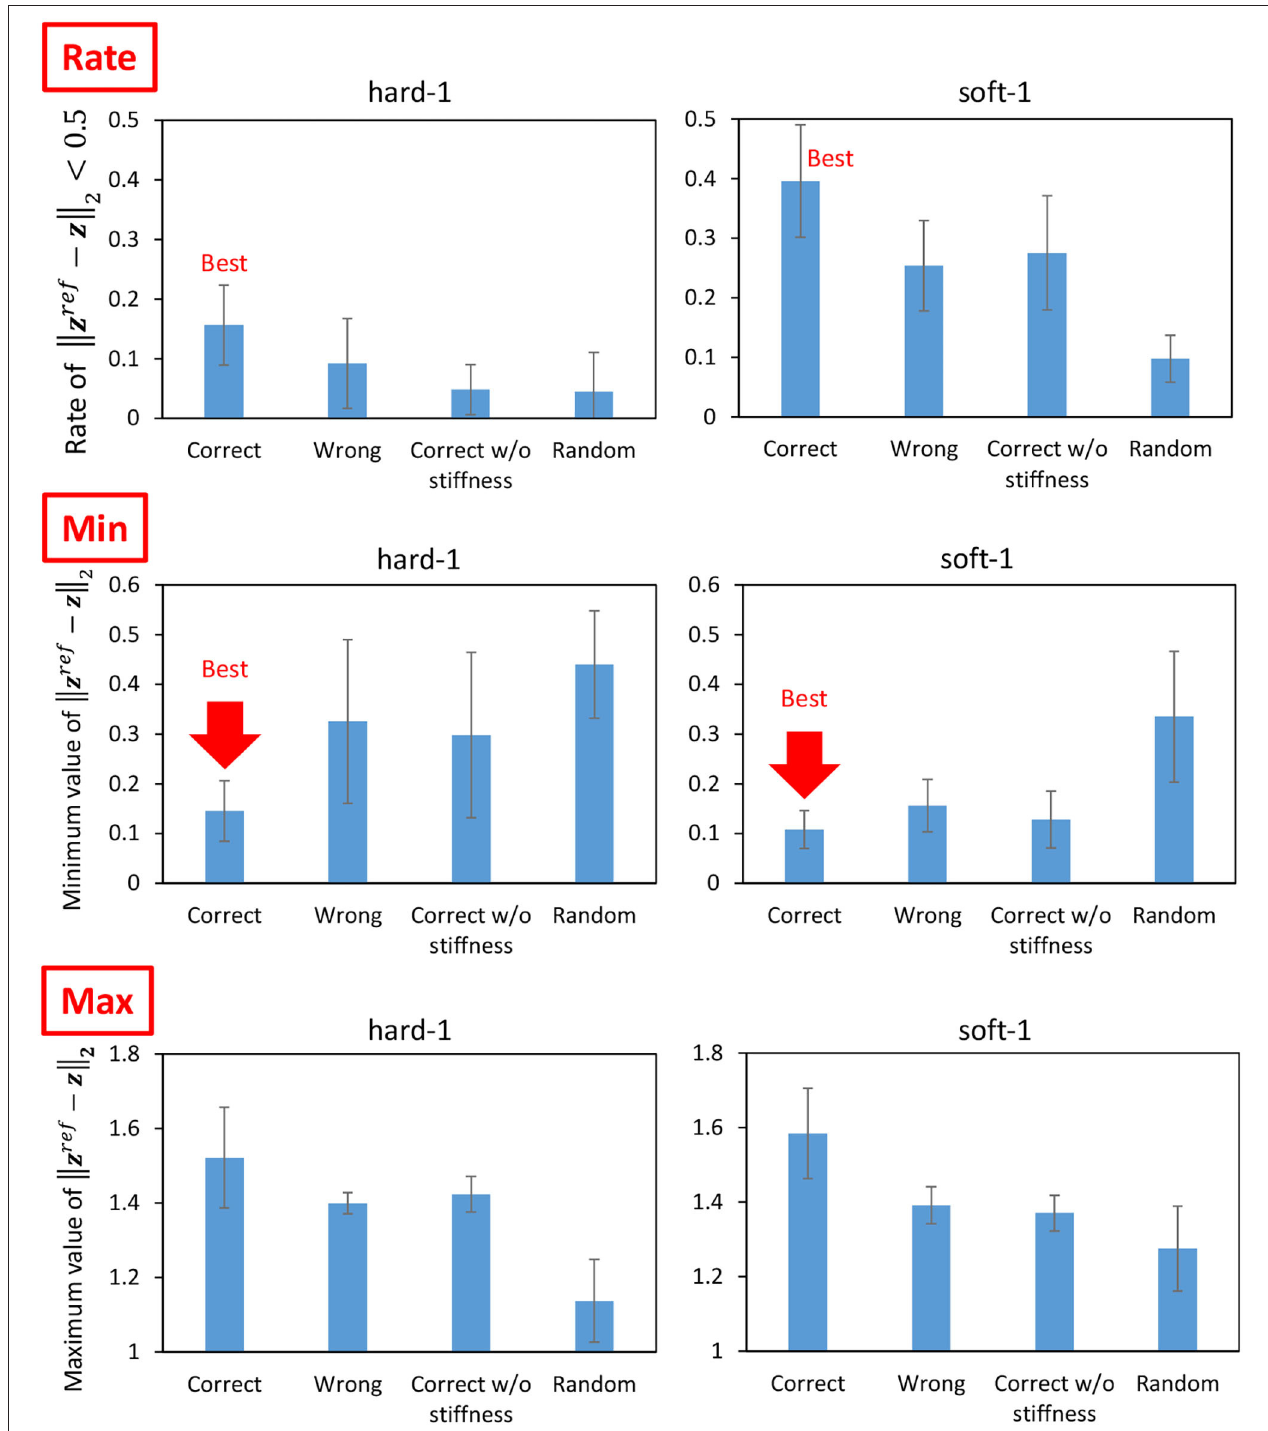
FIGURE 14 | Actual robot experiment: the rate of || z ref − z || 2 < 0.5 (upper graphs) , the minimum value of || z ref − z || 2 (middle graphs) , and the maximum value of || z ref − z || 2 (lower graphs) when conducting experiments of dynamic manipulation of hard-1 and soft-1.